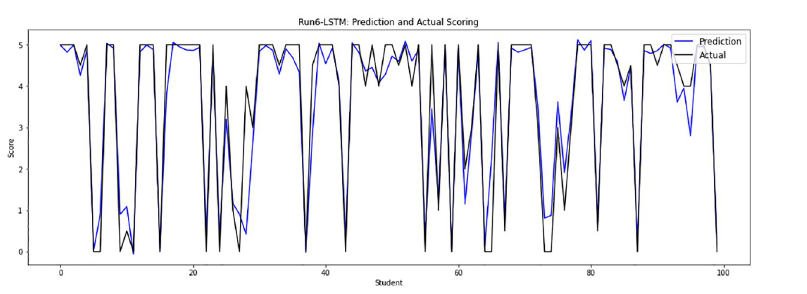
Fig 11. LSTM-GWO prediction and actual scores with experiment 6.